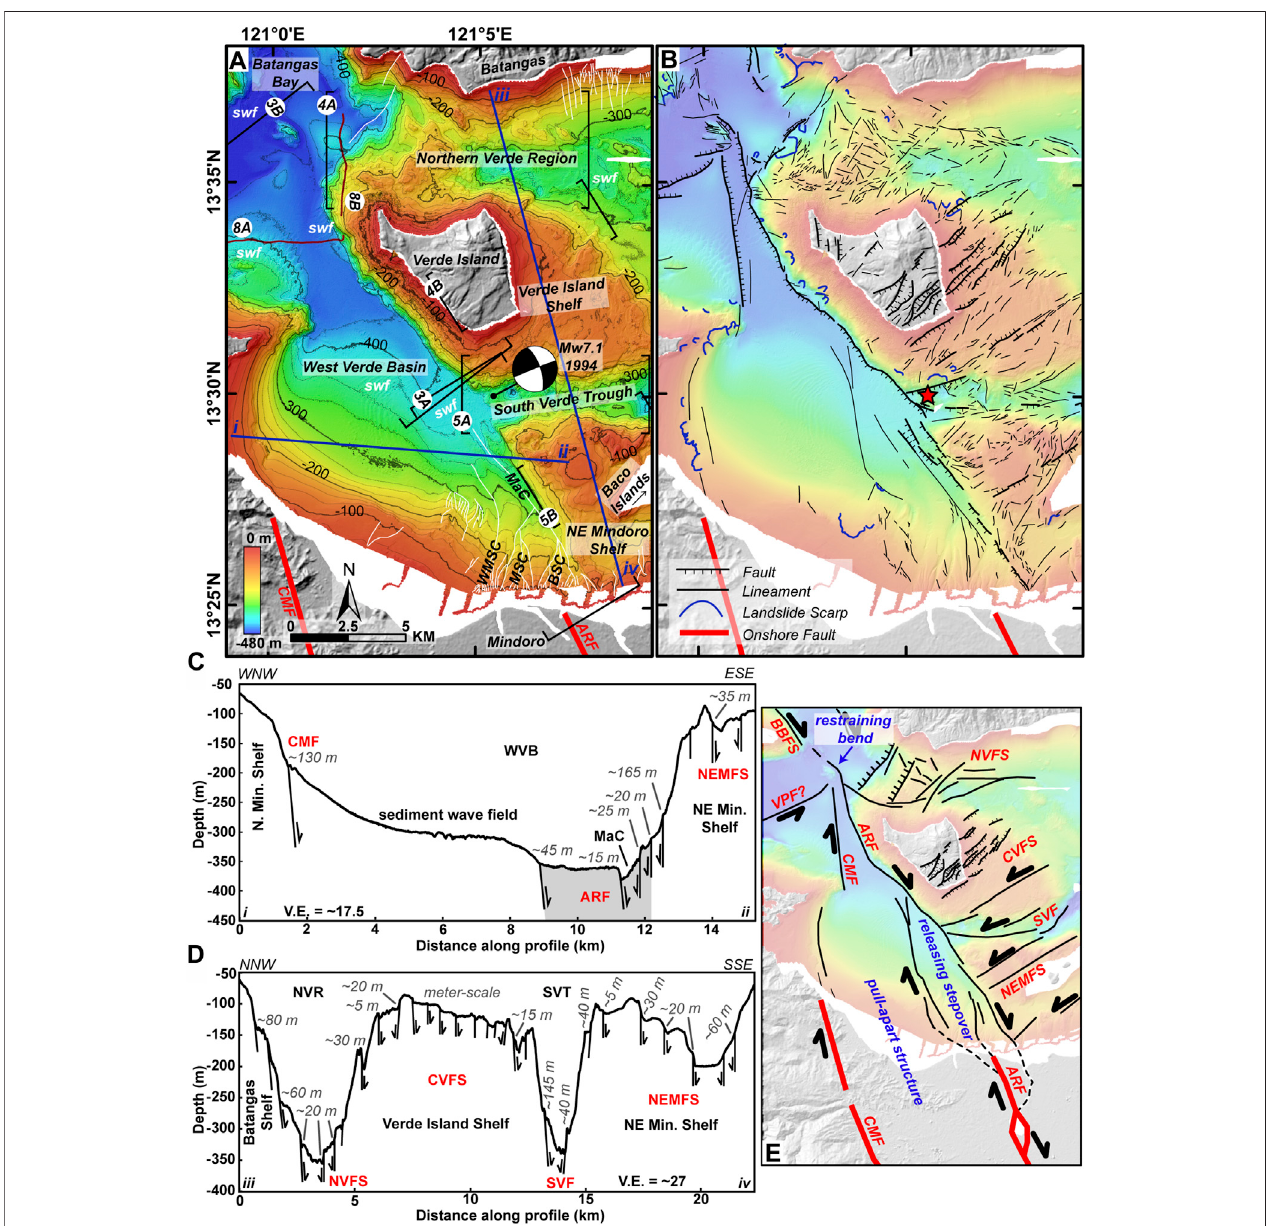
FIGURE 2 | Sea fl oor morphology of Verde Island Passage (VIP) in the vicinity of Verde Island. (A) Physiographic regions de fi ned in VIP. The focal mechanism (GCMT) andlocation(PHIVOLCS)ofthe1994earthquakeareshownforreference.Isobathsareevery25 m.Bracketsshowlocationsofsucceeding fi gures.Subbottom pro fi les are in maroon. Bathymetric pro fi les for 2C and 2D are in blue. White lines indicate gullies. BSC, Baco Submarine Canyon; MSC, Malalay Submarine Canyon; WMSC: West Malalay Submarine Canyon; MaC, Main Canyon; swf: sediment wave fi eld. (B) Interpreted faults, lineaments, and landslide scarps. The epicenter of the 1994 earthquake is shown as a red star. (C) and (D) are bathymetric pro fi les with scarp height values. The shaded region in (C) belongs to the Aglubang River Fault (ARF). (E) Simpli fi ed tectonic interpretation in VIP. CMF, Central Mindoro Fault; NVFS, North Verde Fault System; CVFS, Central Verde Fault System; SVF, South Verde Fault;NEMFS:NortheastMindoroFaultSystem;BBFS:BatangasBayFaultSystem;VPF,VerdePassageFault;WVB,WestVerdeBasin;NEVB,NortheastVerdeBasin; SVT, South Verde Trough.